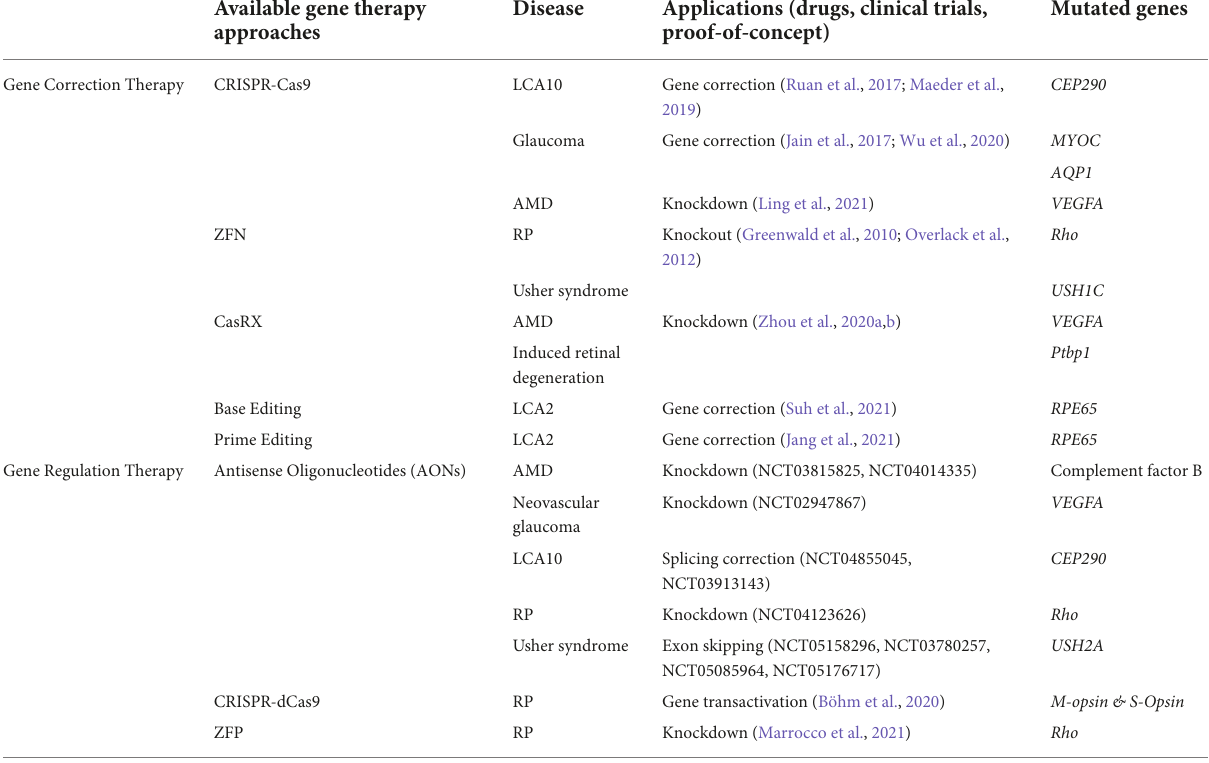
TABLE 1 Preclinical and clinical studies using gene correction and gene regulatory